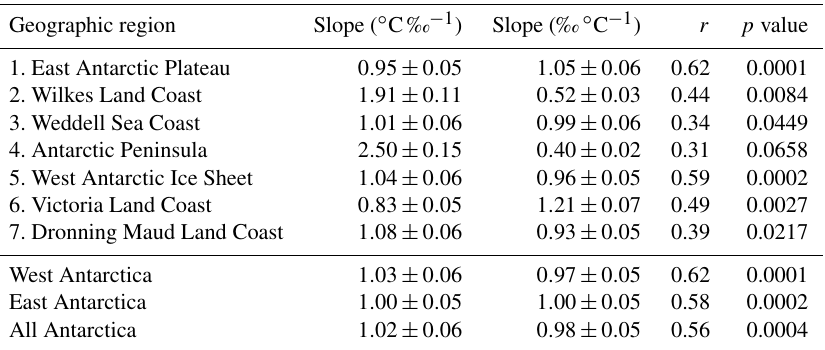
Figure 4. Regional temperature ( T anomalies in ◦ C, referenced to the 1960–1990CE interval) reconstructions using 5-year-binned data for the past 200 years. The weighing method is based on the correlation between site T and regional T from NB2014. The temperature scaling method is (i) based on the correlation between annual mean regional δ 18 O and regional T from ECHAM5-wiso forced by ERA- Interim (coloured lines) and (ii) scaled on the NB2014 target over 1960–1990CE (grey lines), and the (iii) West Antarctic Ice Sheet region is adjusted to match the temperature trend between 1000 and 1600CE based on borehole temperature measurements (black line; Orsi et al., 2012). Linear trends are calculated over the last 100 years of the reconstructions (colours match associated reconstruction methods). The map at the centre reports regional trends over the last 100-year trend using 5-year data based on the ECHAM method adjusted for the West Antarctic Ice Sheet region to borehole data. Hatched areas are not significant ( p > 0 . 05). Table 1. Linear regression analysis (slope with ± 1 σ uncertainty, correlation coefficient r , and p value) of the simulated δ 18 O–temperature relationships extracted from the ECHAM5-wiso model for each climatic region, as well as the broad East Antarctic, West Antarctic and whole of Antarctica